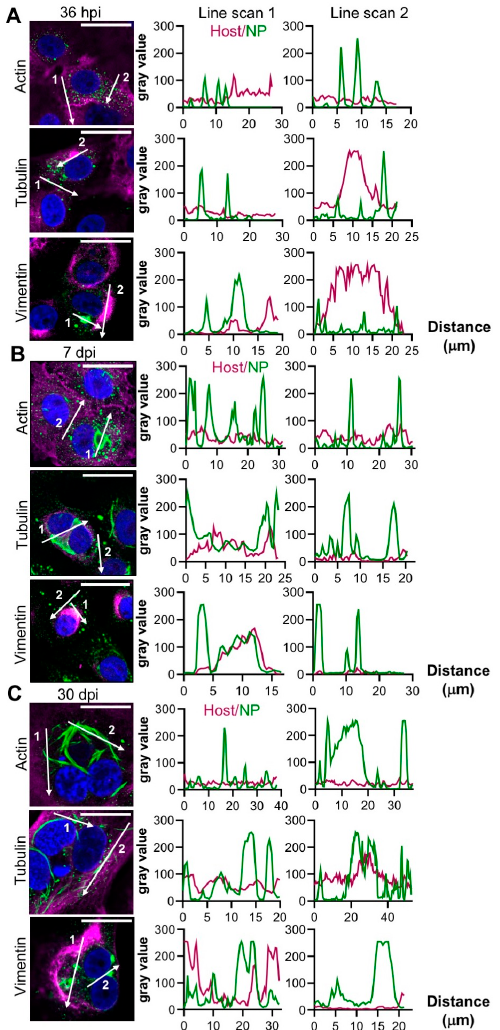
Figure 3. Co-localisation between the TULV NP and cytoskeletal filaments at the early, peak and persistent stages of TULV infection in Vero E6 cells. The spatial distribution of the cytoskeletal markers actin, tubulin and vimentin (magenta) was observed alongside TULV NP (green) in Vero E6 cells infected with TULV at a MOI of 0.1 by confocal microscopy at 40× magnification at ( A ) 36 h post infection (hpi), ( B ) 7 days post infection (dpi), and ( C ) 30 dpi. The scale bar represents 30 µ m. Fluorescent line scans were taken using Fiji software with the designated number labels corresponding to adjacent line scan plots. Nuclei were stained with DAPI (blue), the TULV NP was detected using NP antisera and the cytoskeleton was detected using primary antibodies against β -actin, β -tubulin and vimentin. Images shown in panels A, B and C show the representative analysis of 87, 109 and 58 cells,